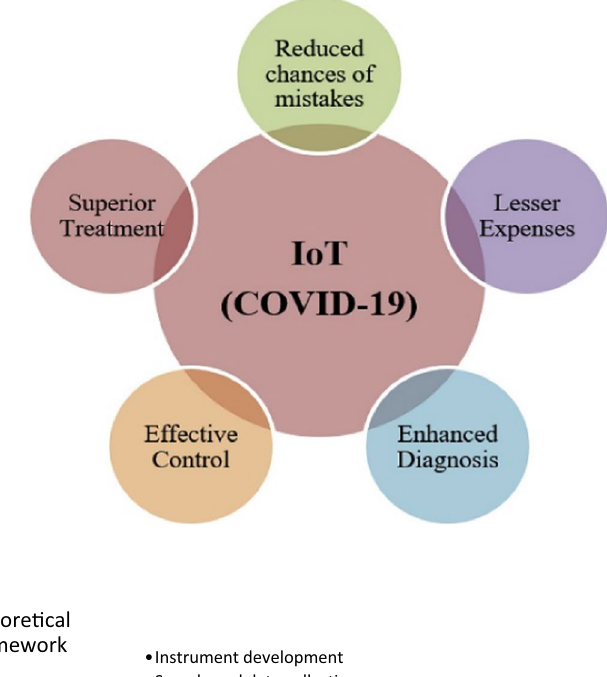
Fig. 4 Organization of the